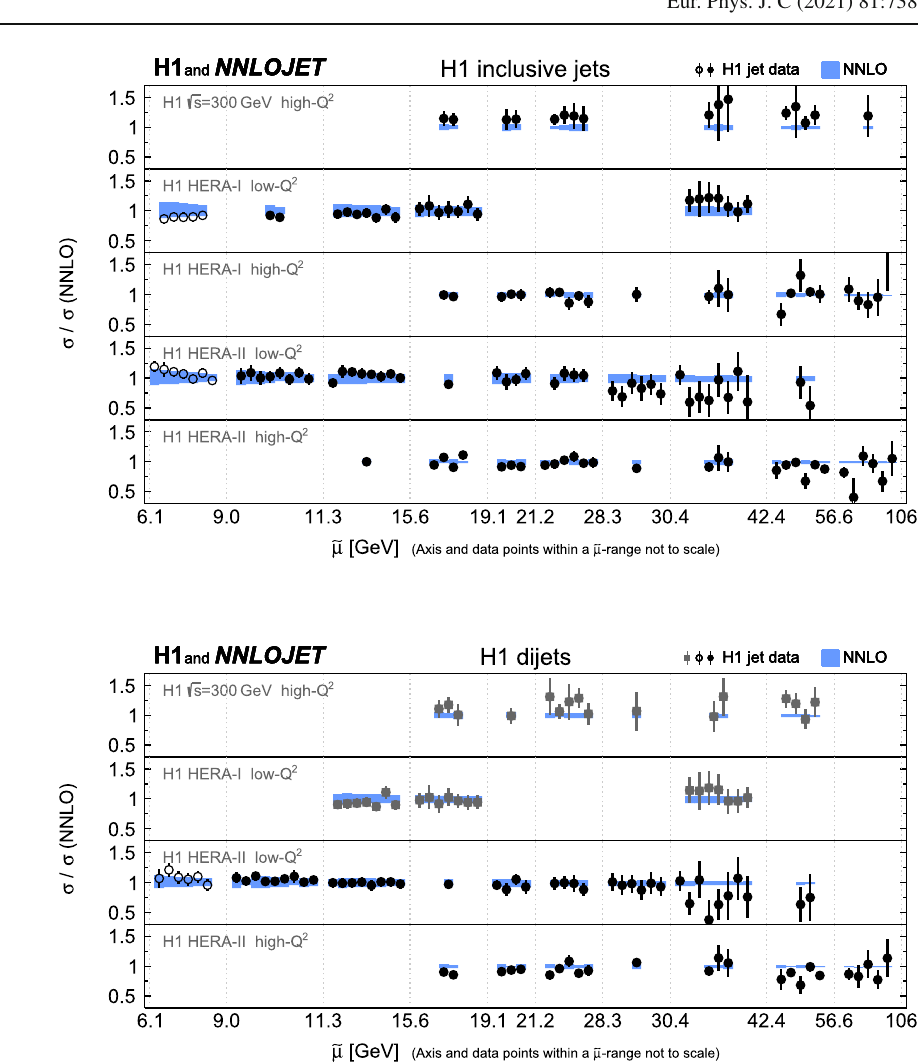
Table 5 Values of the strong coupling constant α s (μ R ) and at the Z - boson mass, α s ( m Z ) , obtained from fits to groups of data points with comparable values of μ R . The first (second) uncertainty of each point Running of the strong